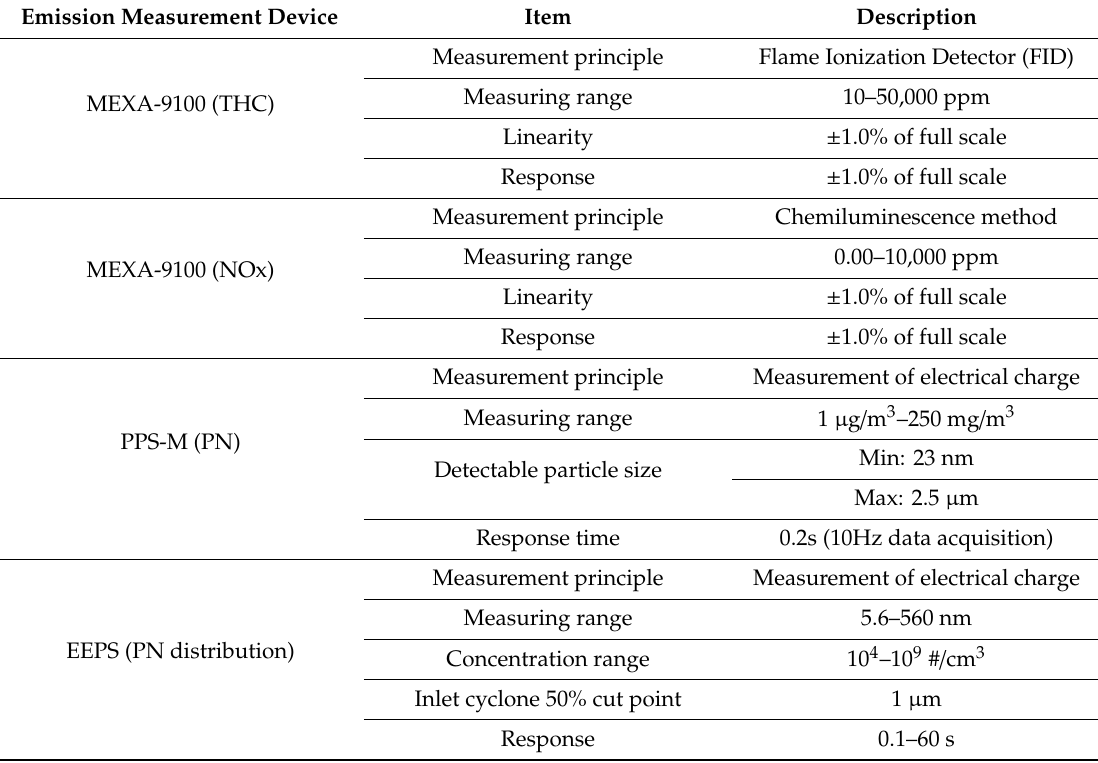
Table 3. Specifications of the gas and particle emissions measurement